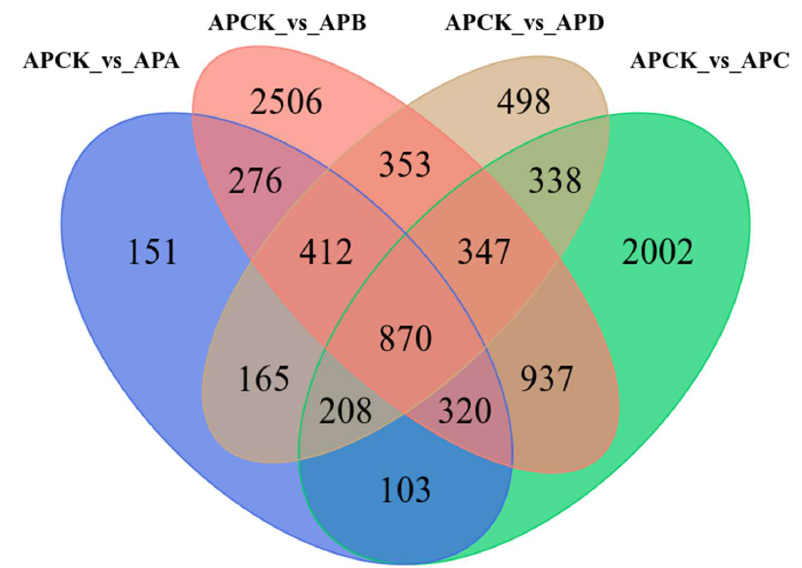
Figure 3. Wayne diagram of A. pseudosieboldianum and DEGs of CK (4 ◦ C) under different temperature Figure 3 . Wayne diagram of A. pseudosieboldianum and DEGs of CK (4 °C) under different tempera- ture freezing stress. They provide a comparison between −10 °C treatment and 4 °C treatment, −20 freezing stress. They provide a comparison between − 10 ◦ C treatment and 4 ◦ C treatment, − 20 ◦ C °C treatment and 4 °C treatment, −30 °C treatment and 4 °C treatment, and −40°C treatment and 4°C treatment and 4 ◦ C treatment, − 30 ◦ C treatment and 4 ◦ C treatment, and − 40 ◦ C treatment and treatment. 4 ◦ C treatment.